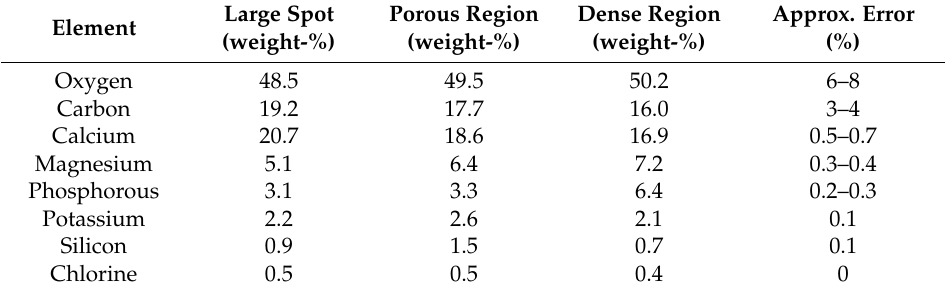
Table 1. Elemental compositions estimated from electron-dispersive X-ray spectroscopy of three distinct regions in a cross-polished urinary stone of a guinea pig. The values represent weight percentages that have been normalized to